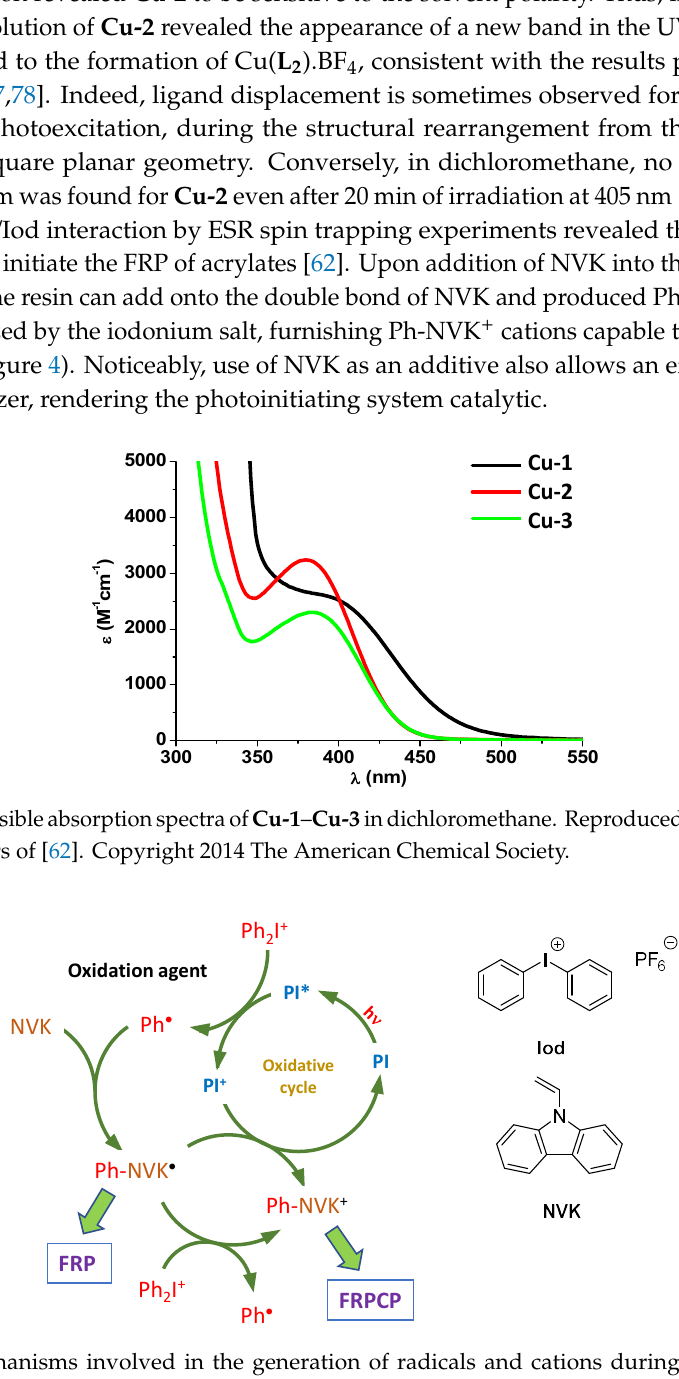
Figure 4. Mechanisms involved in the generation of radicals and cations during the free radical polymerization (FRP) and the free radical promoted cationic polymerization